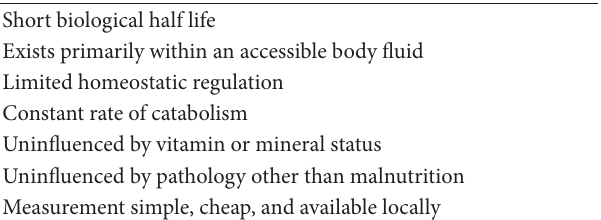
T 2: Features of the ideal protein-energy